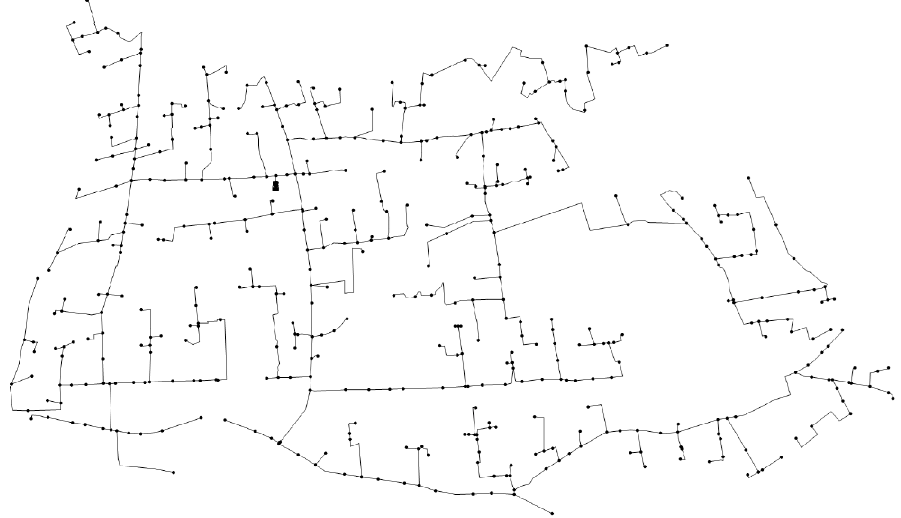
Figure 2. Network skeleton (steady state analysis, case 1). Water 2018 , 9 , 763